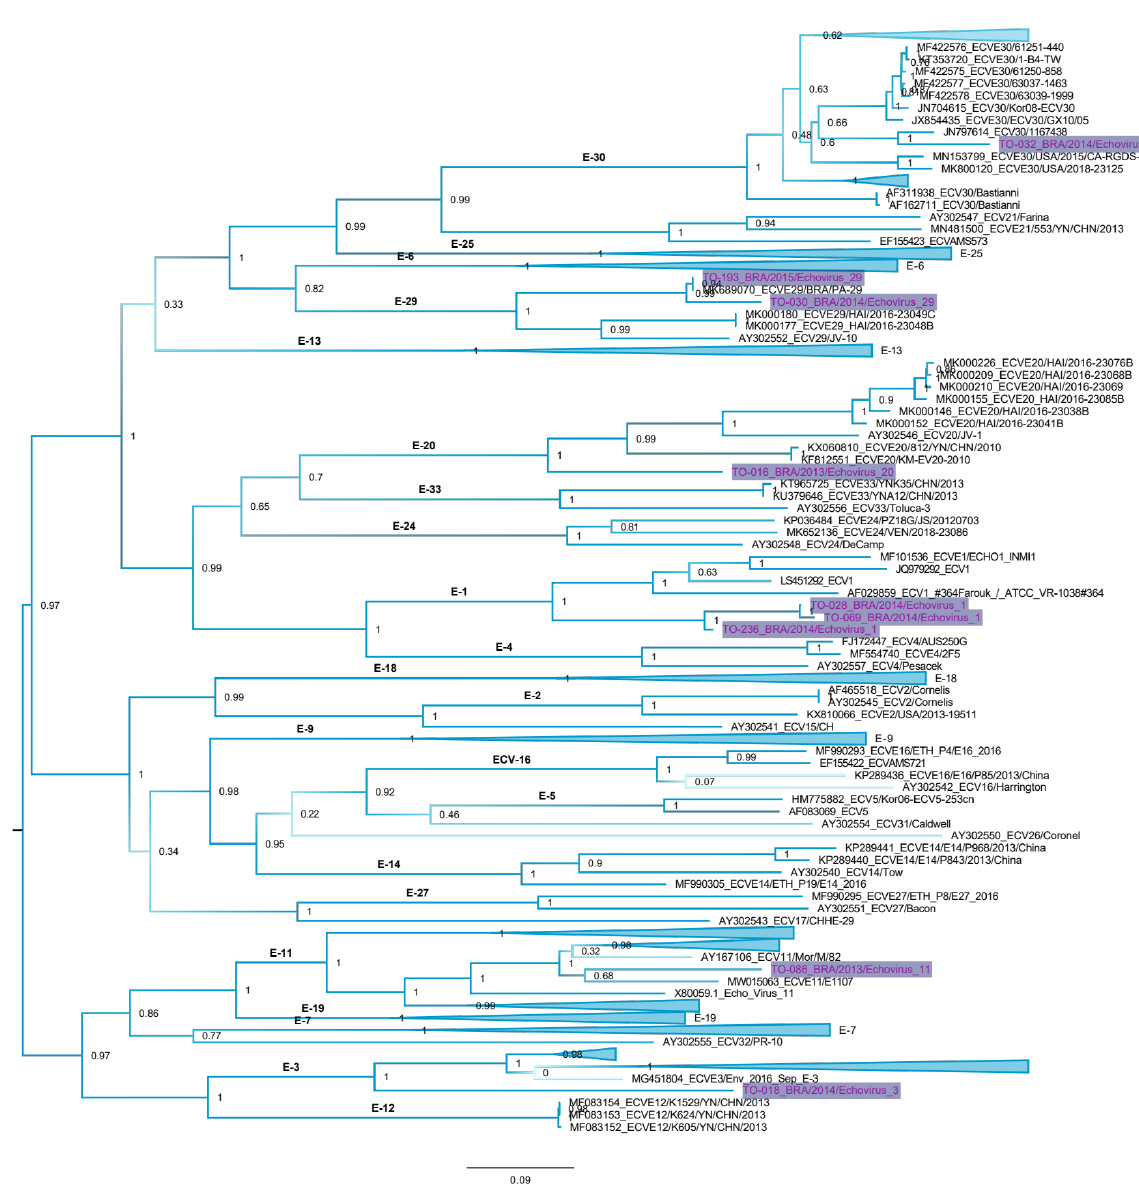
Figure 2. Maximum likelihood tree of VP genome region of enteroviruses. Numbers in each node are the statistical support based on the approximate likelihood test. Echovirus clades are indicated in the tree. Sequences were named following: GenBank ID or number_ country of origin/year of isolation_ genotype. Echoviruses characterized in this study were highlighted in the tree. In order to facilitate visualization, some clusters were collapsed in the tree.